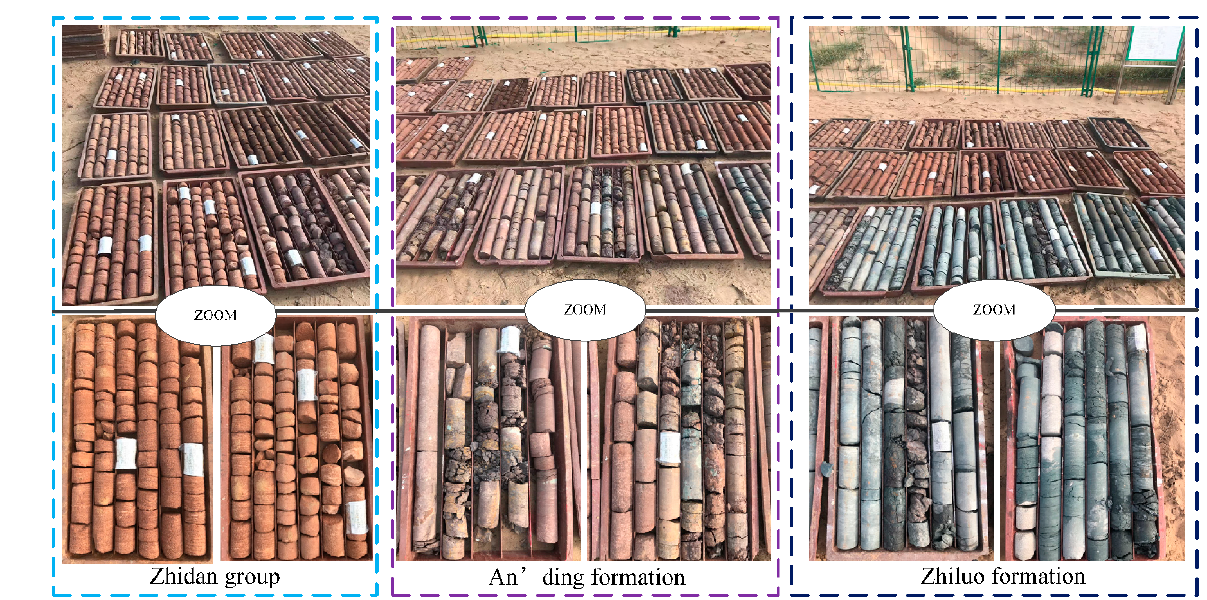
Figure 4. The rock samples from the surface to the boreholes on the coal seam. Table 5. Quantitative analysis table of total rock X-ray diffraction.